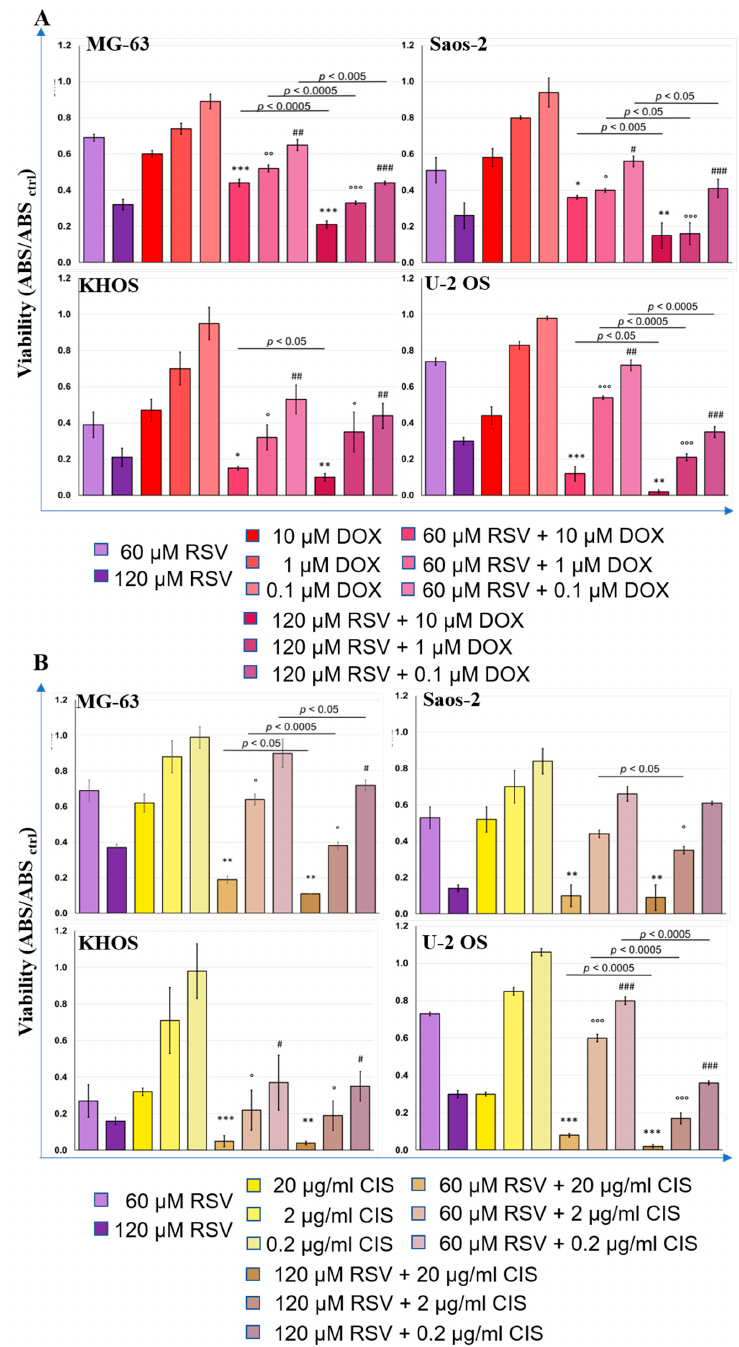
2 Figure 8. Results of RSV–DOX ( A ) and RSV–CIS ( B ) effects on OS cell lines viability (WST-1) (mean ± SD, n = 4). Each OS cell line culture was RSV pretreated (60 or 120 µ M) in 48 h and then treated with DOX (10, 1, or 0.1 µ M) or CIS (20, 2, or 0.2 µ g/mL) within 24 h, except for control treatment cultures. These last were treated with DOX (10, 1, or 0.1 µ M) or CIS (20, 2, or 0.2 µ g/mL) within 24 h or with RSV (60 or 120 µ M) within 48 h. The WST-1 values of OS cell control cultures (ABS CTRL ) correspond to 1.0. After having observed a significant effect of the combined treatment factor (RSV–DOX or RSV–CIS) on cell viability ONE, pairwise comparison tests between treatment combinations and relative treatment controls were done. For each symbol (*, IC 50 , ◦ , 10 − 1 IC 50 and #, 10 − 2 IC 50 dose of DOX or CIS) 1 symbol corresponds to p < 0.05; 2 symbols, p < 0.005; and 3 symbols, p < 0.0005. The line over bars highlights the presence of a significant difference between the two